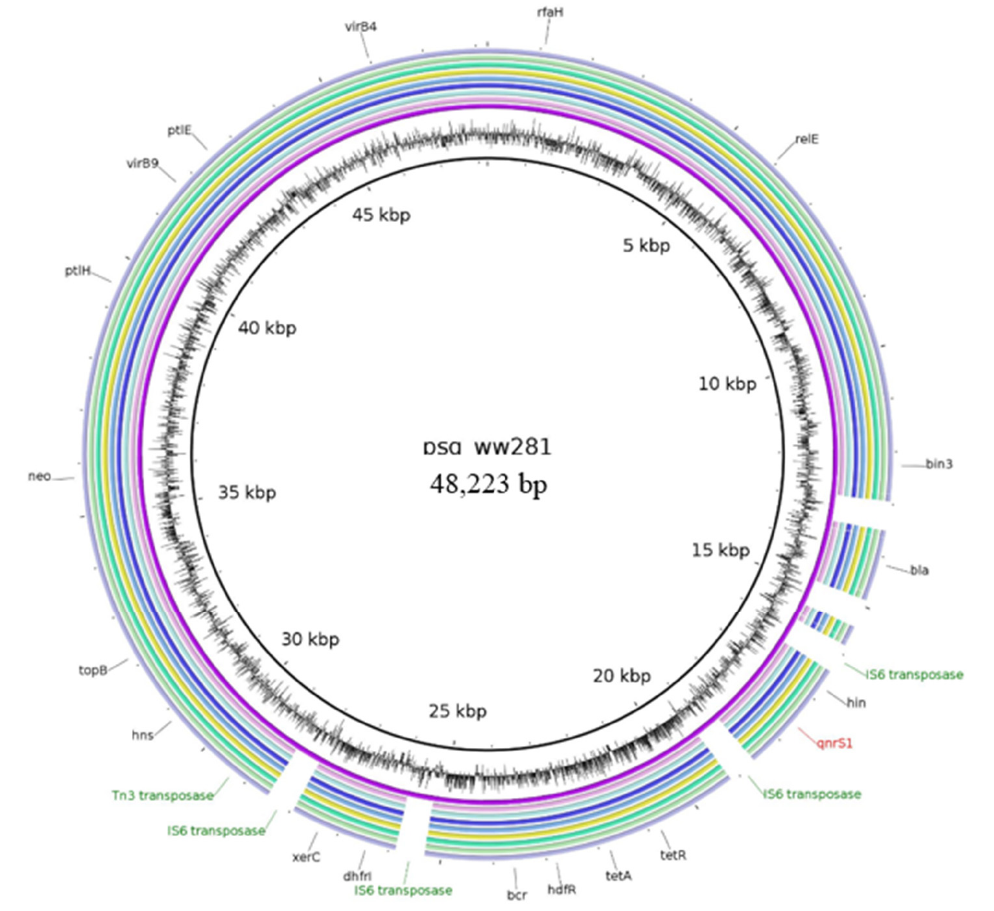
Figure 3. BRIG image of sequence contigs of the individual isolates assigned to the reference plasmid psg_ww281 (NZ_CP031373). Contigs belonging to the isolates as follows (from inner to outer